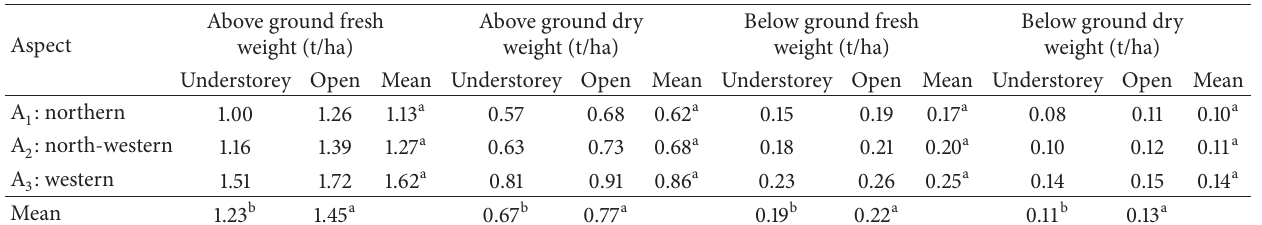
Table 3: Effect of aspect on biomass and yield (t/ha) of Andrographis paniculata in understorey and open conditions. Above ground fresh Aspect weight (t/ha)